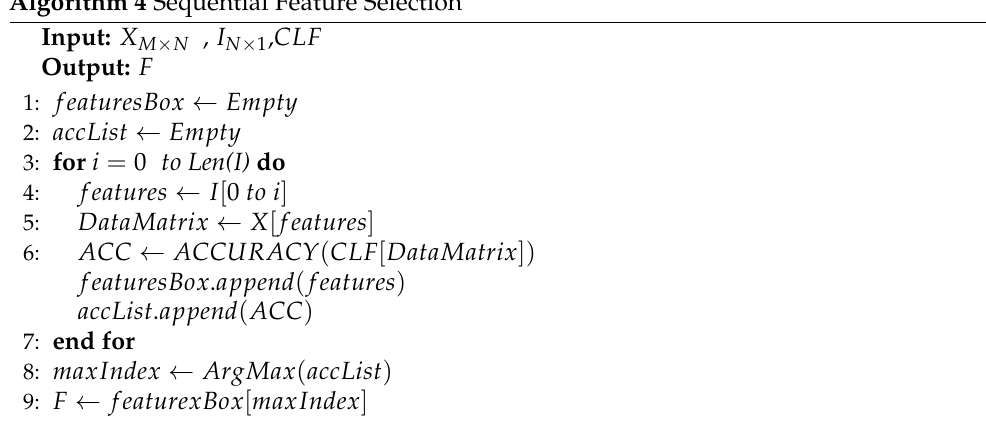
Algorithm 4 Sequential Feature